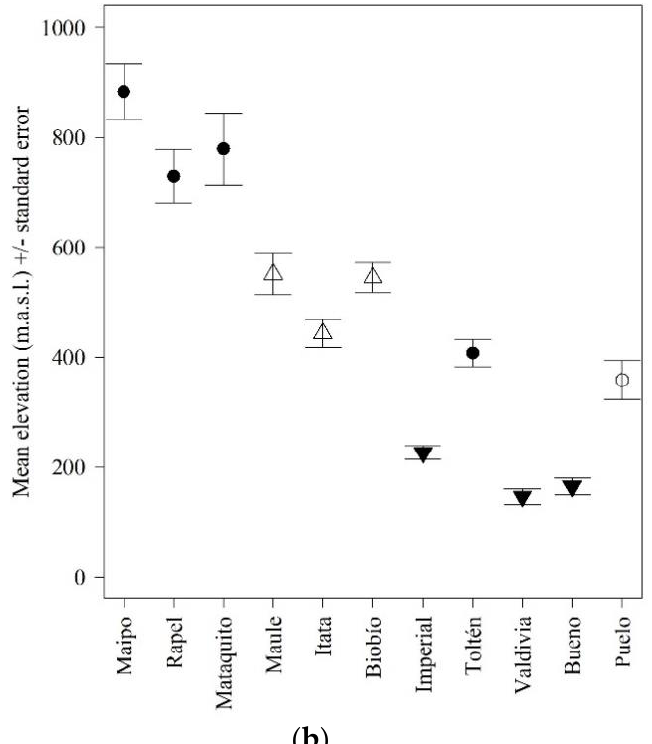
Figure 4. ( a ) Range of elevations of each FPZs in the eleven river basins. ( b ) Mean elevation of each of the river basin calculated from elevations of all defined river sections (symbols indicate groups at 65% similarity).